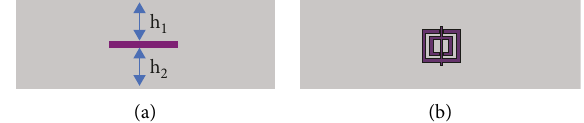
Figure 9: The substrate of the proposed metamaterial fractal antenna. (a) Front view. (b) Top